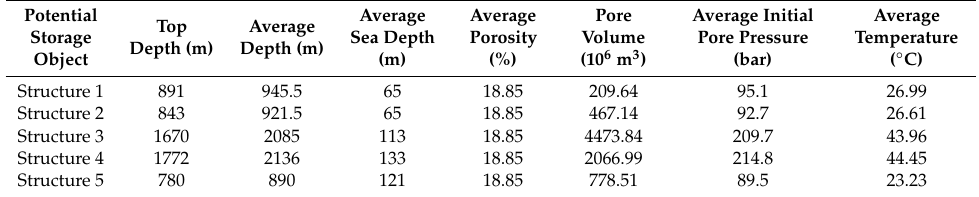
Table 3. Main characteristics of structurally defined aquifers in carbonates.